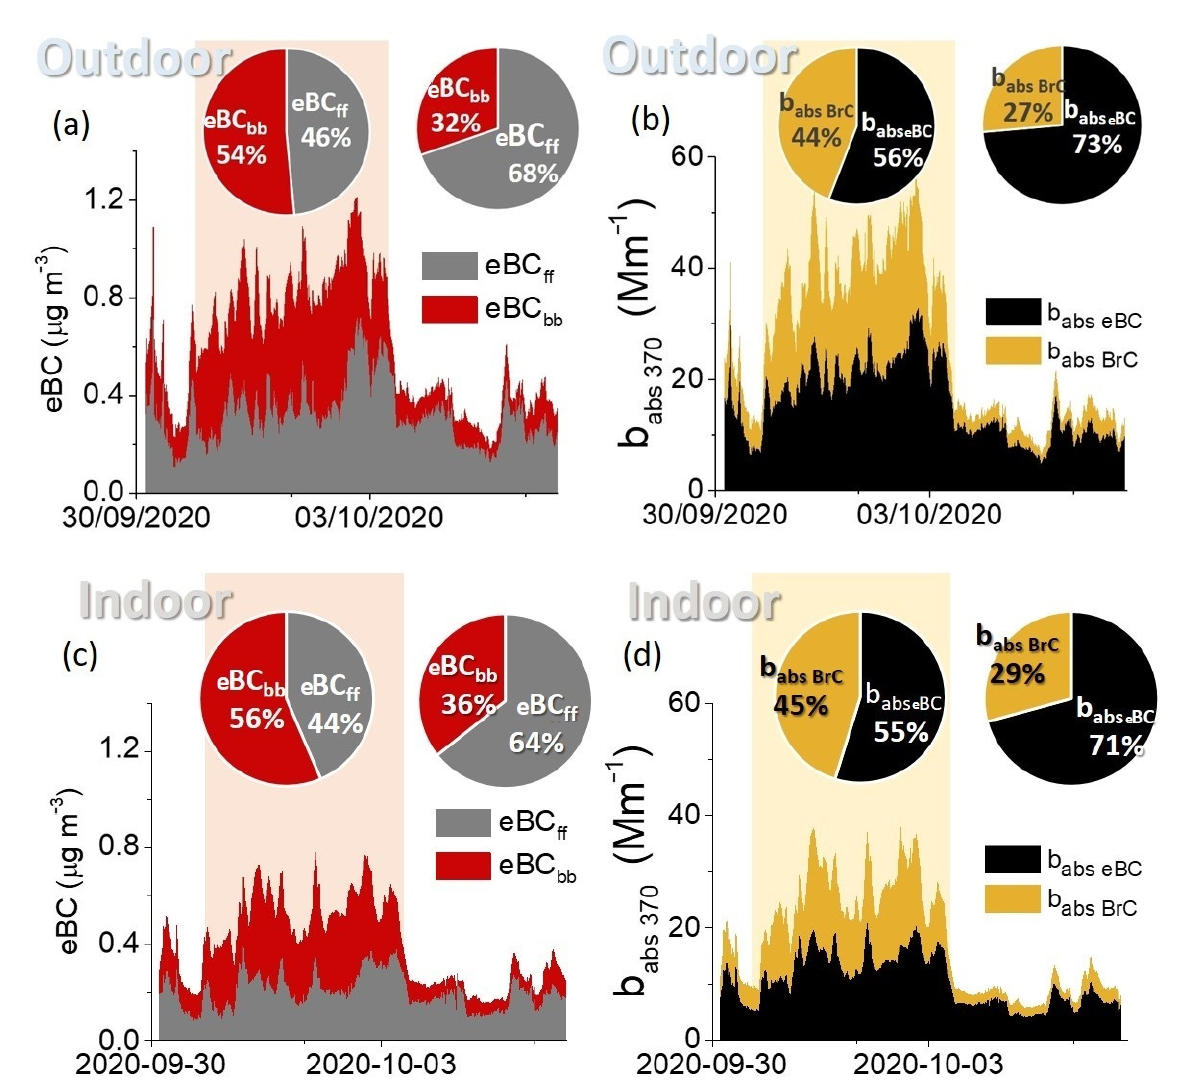
Figure 5. Time series of eBC ff and eBC bb mass concentrations in outdoor ( a ) and indoor ( c ) air. Time series and contributions of b abs BrC and b abs eBC to total b abs in outdoor ( b ) and indoor ( d ) air. The pink and yellow areas mark the smoke event. Pie charts represent contributions of each parameter during non-event and event days.